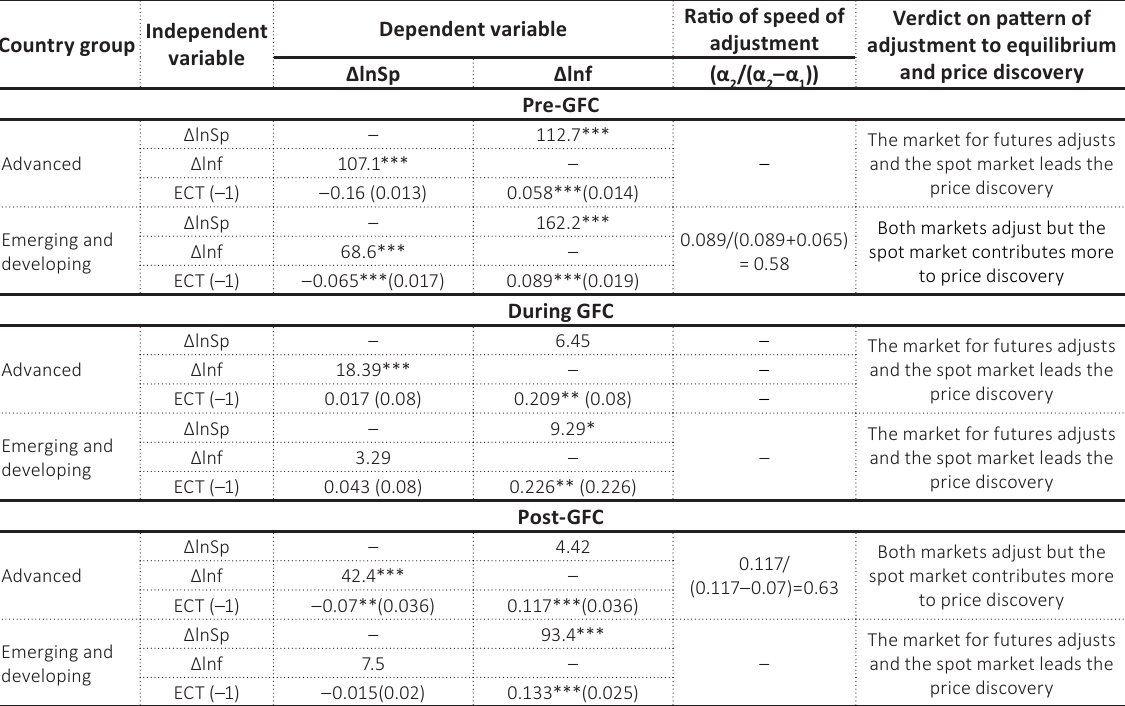
Table 5. VECM results for country groups in pre-GFC, GFC and post-GFC